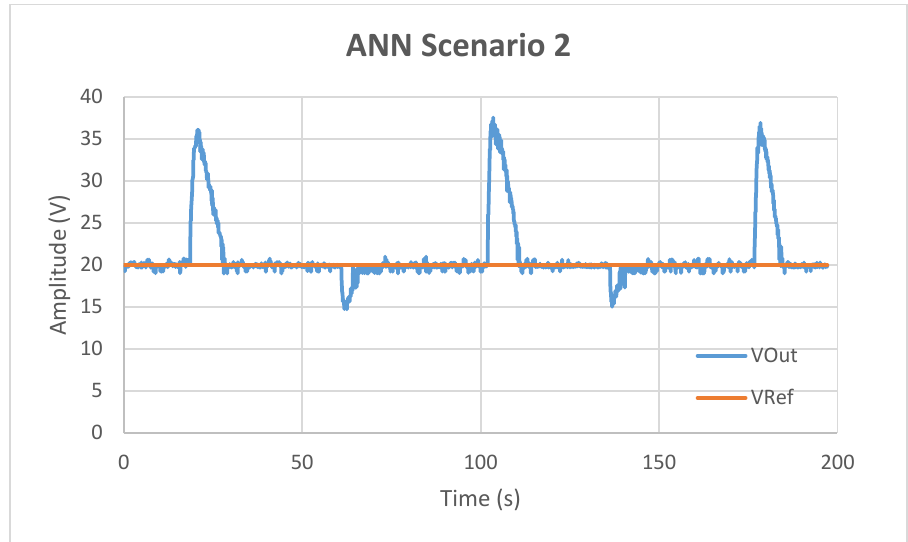
Figure 21. The response results of load changes with artificial neural network controller.